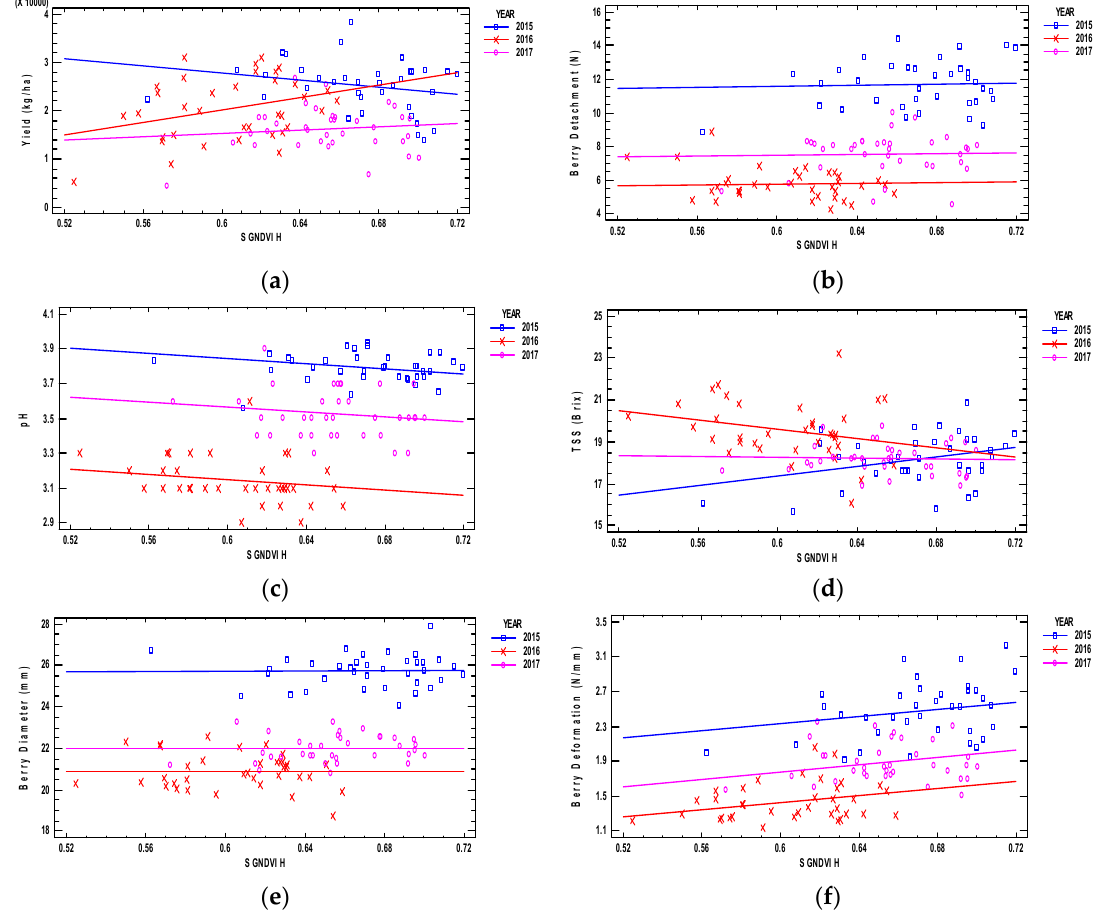
Figure 4. Scatterplots of S GNDVI H with ( a ) yield, ( b ) berry detachment, ( c ) pH, ( d ) total soluble solids, ( e ) berry diameter, and ( f ) derry deformation.